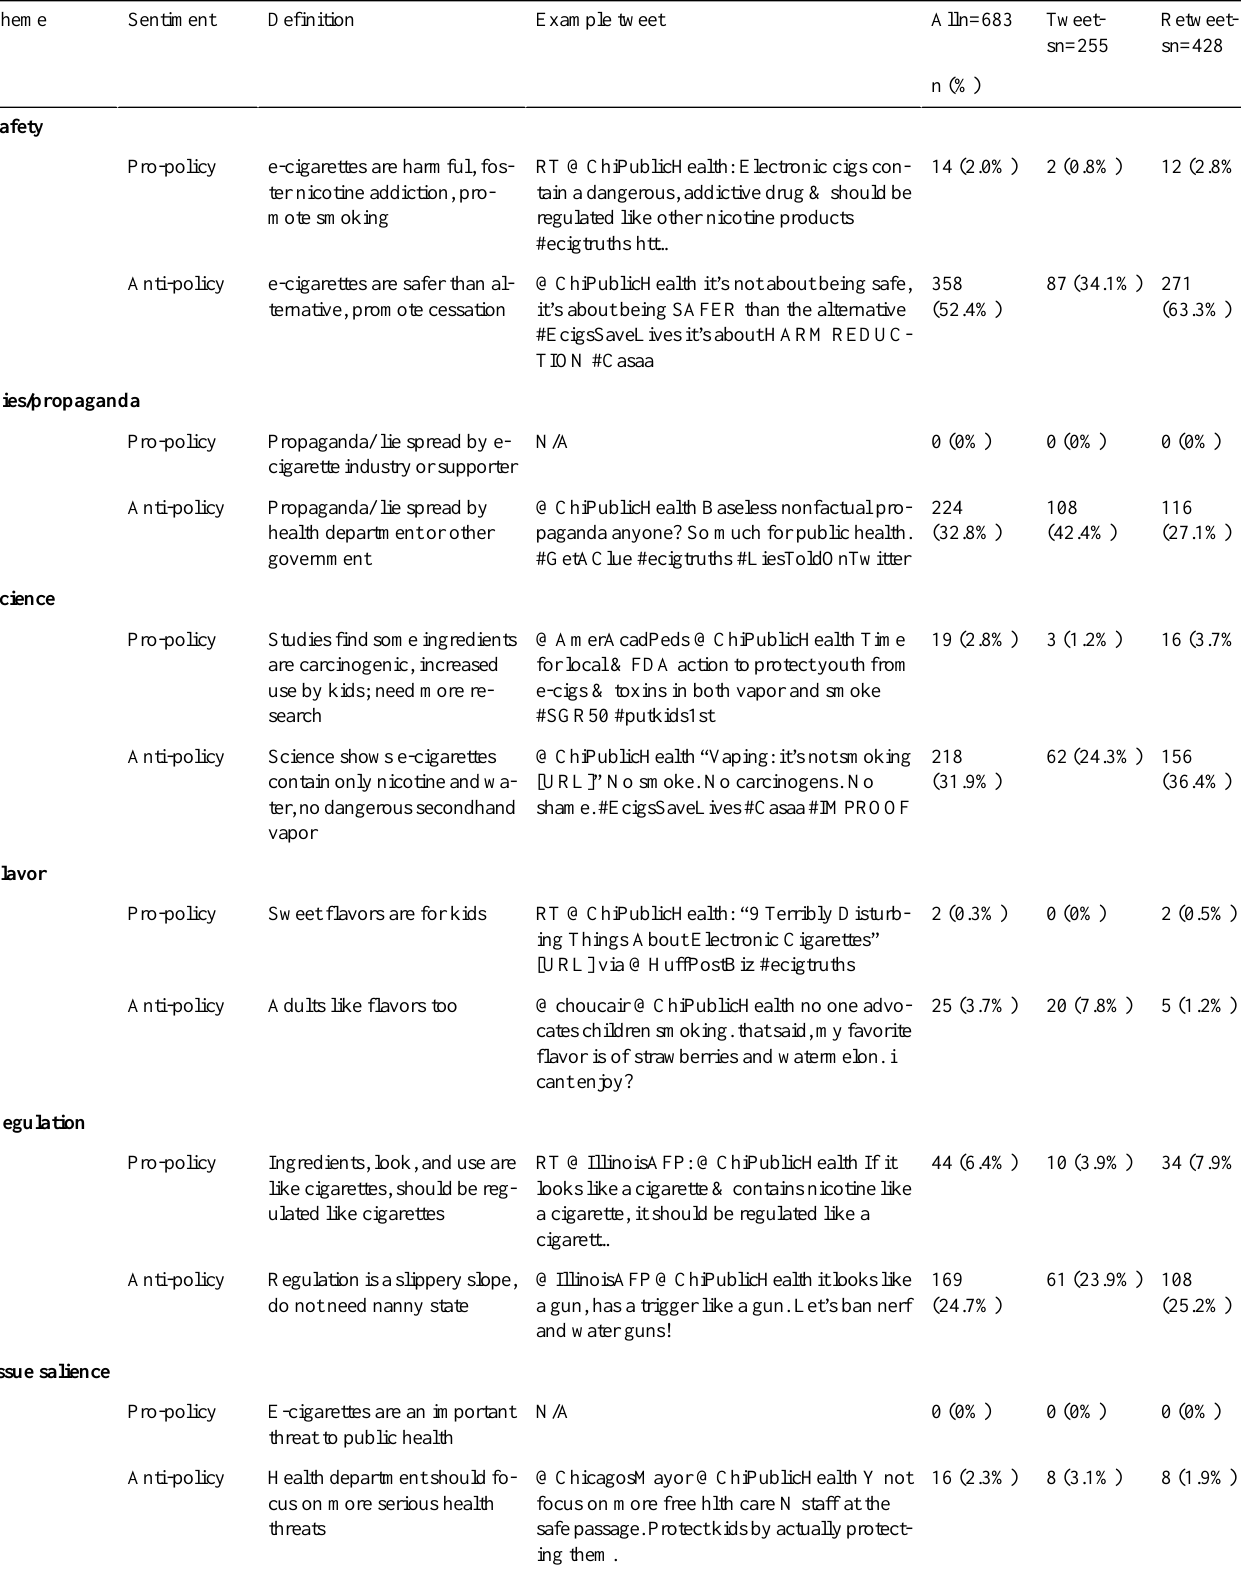
Table 2. Themes in e-cigarette tweets mentioning the Chicago Department of Public Health in January, 2014 a